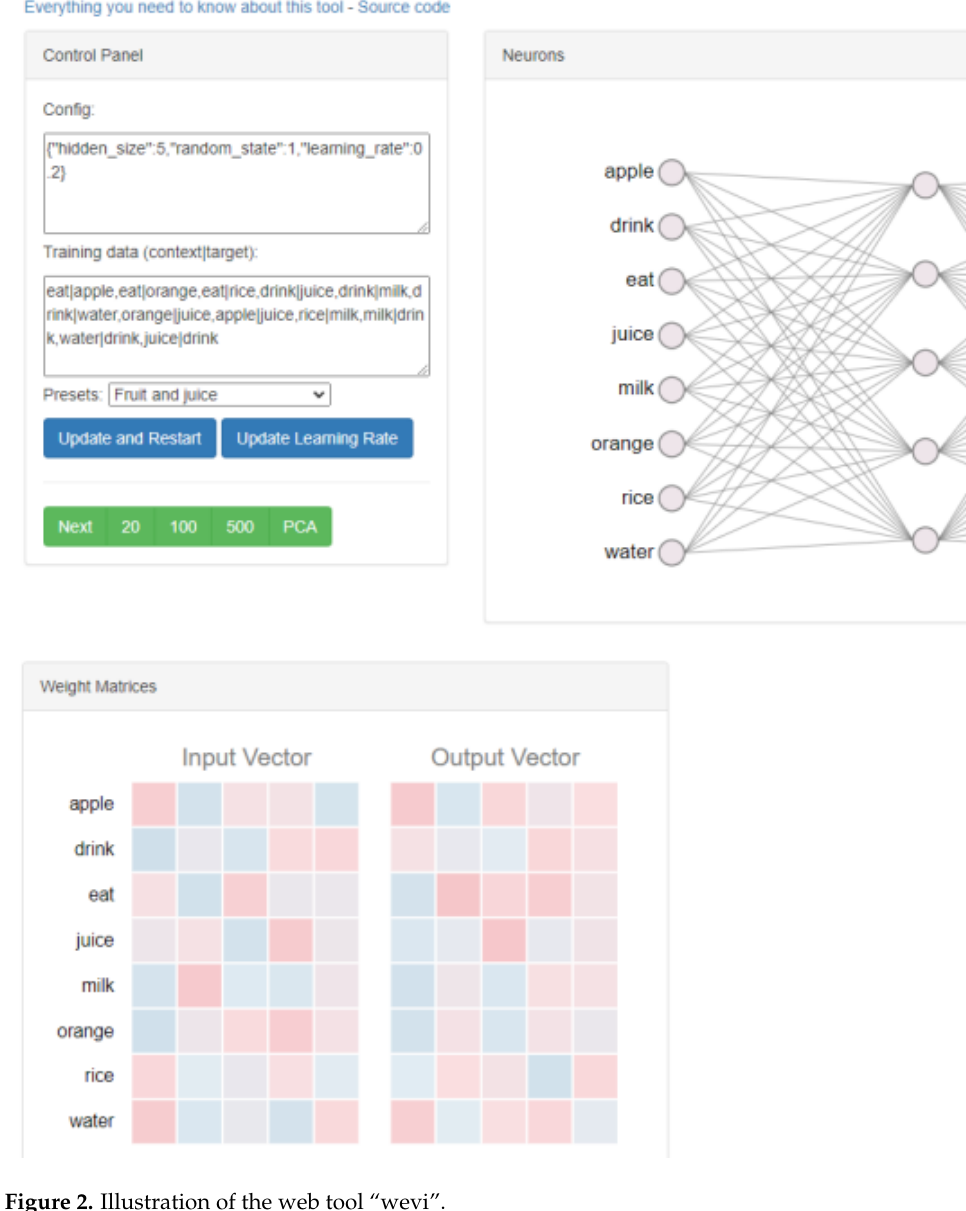
8 of 20 Figure 1. Illustration of the window for creating a context of the word “like” through W2V. The second possible architecture is the Continuous Skip-gram. This architecture is